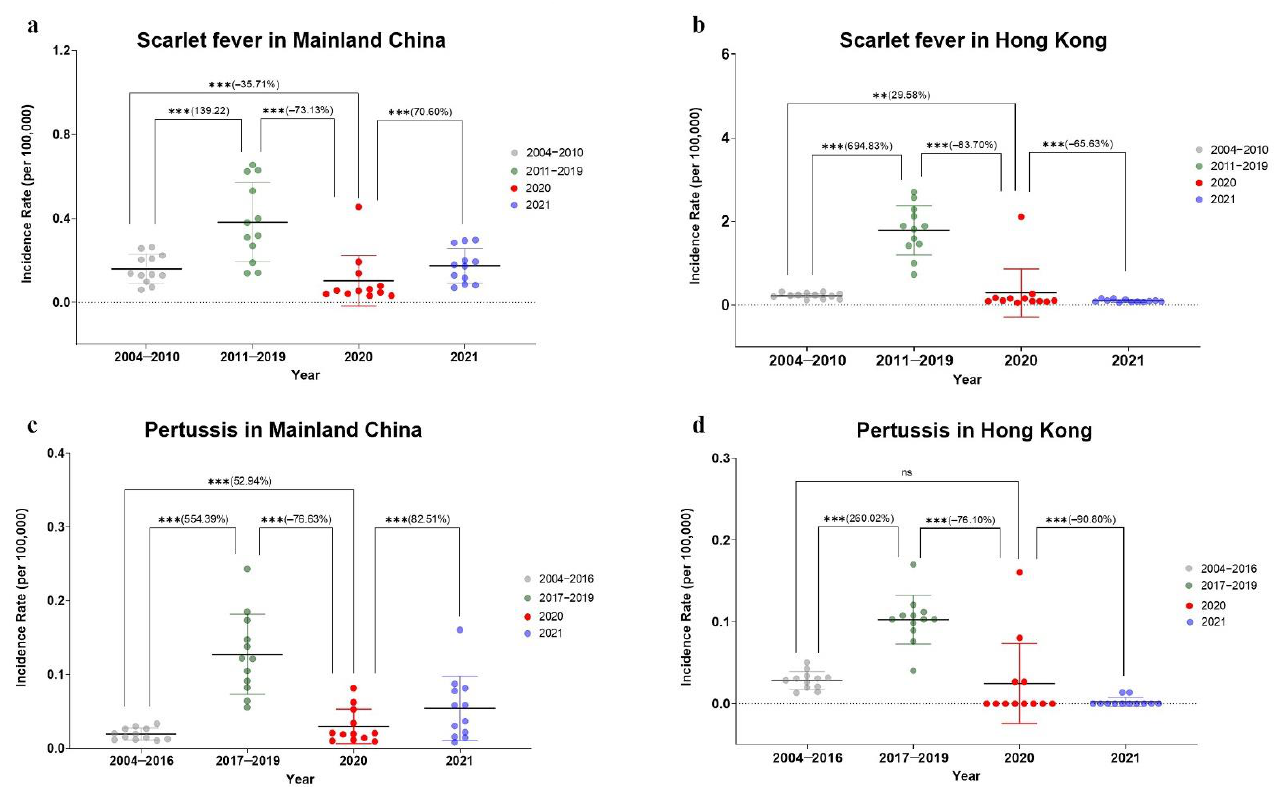
Figure 4. Comparison of yearly incidence rates (1/100,000) of scarlet fever and pertussis. ( a ) Scarlet